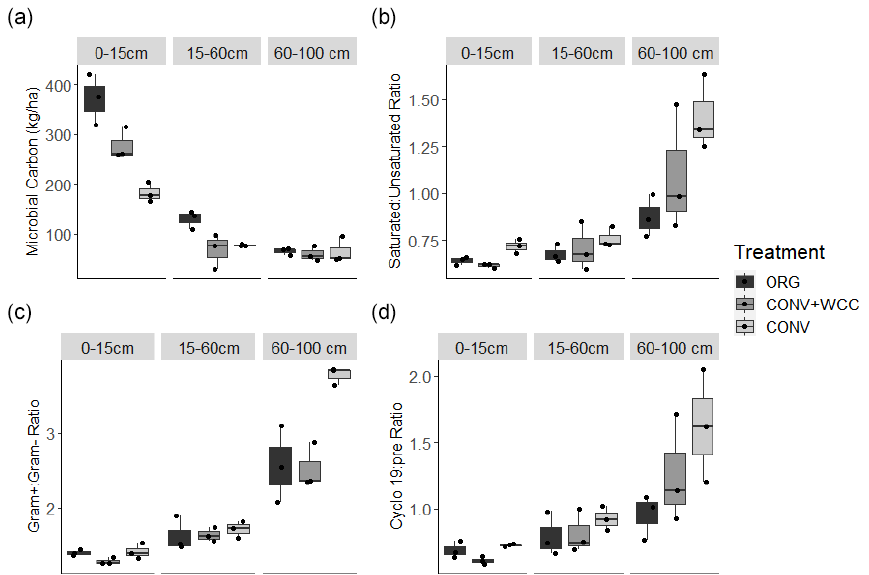
Figure 9. (a–d) Microbial biomass and PLFA stress indicators measured in ORG, CONV + WCC, and CONV systems during mid-season (July 2018). Ratios are unitless, while microbial biomass is given in kilograms per